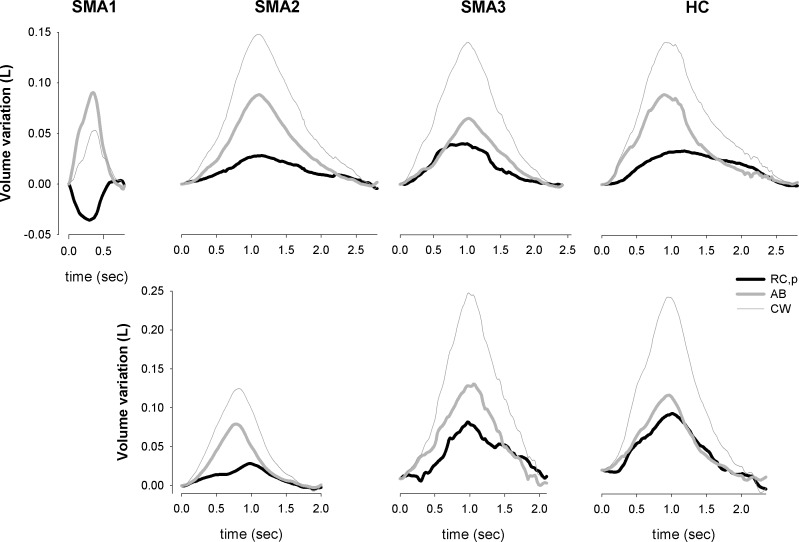
Representative traces of chest wall (CW, thin grey line), pulmonary ribcage (RC,p, black line) and abdominal (AB, bold grey line) volume variations during spontaneous quiet breathing in one represented subject belonging to SMA types I, II, III and healthy children (SMA1,SMA2, SMA3 and HC, respectively).In supine position (upper panels), the reduced tidal volume, the increased respiratory rate and the inspiratory paradoxical indrawing of the pulmonary ribcage compensated by increasing abdominal contribution in SMA1 are evident. Only in seated position (lower panels), in SMA2 total and compartmental volume change are reduced.